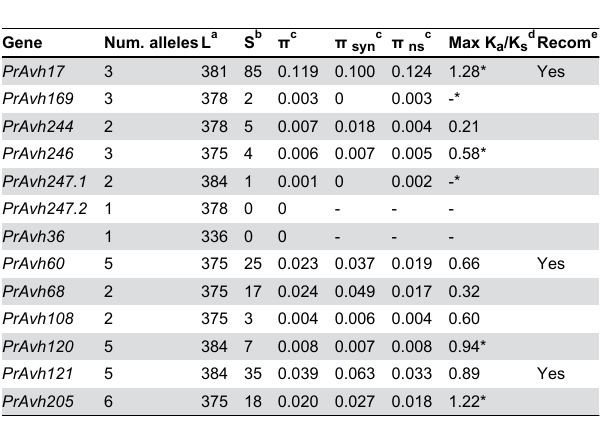
Table 1. Nucleotide polymorphism in coding sequences of P. ramorum PrAvh